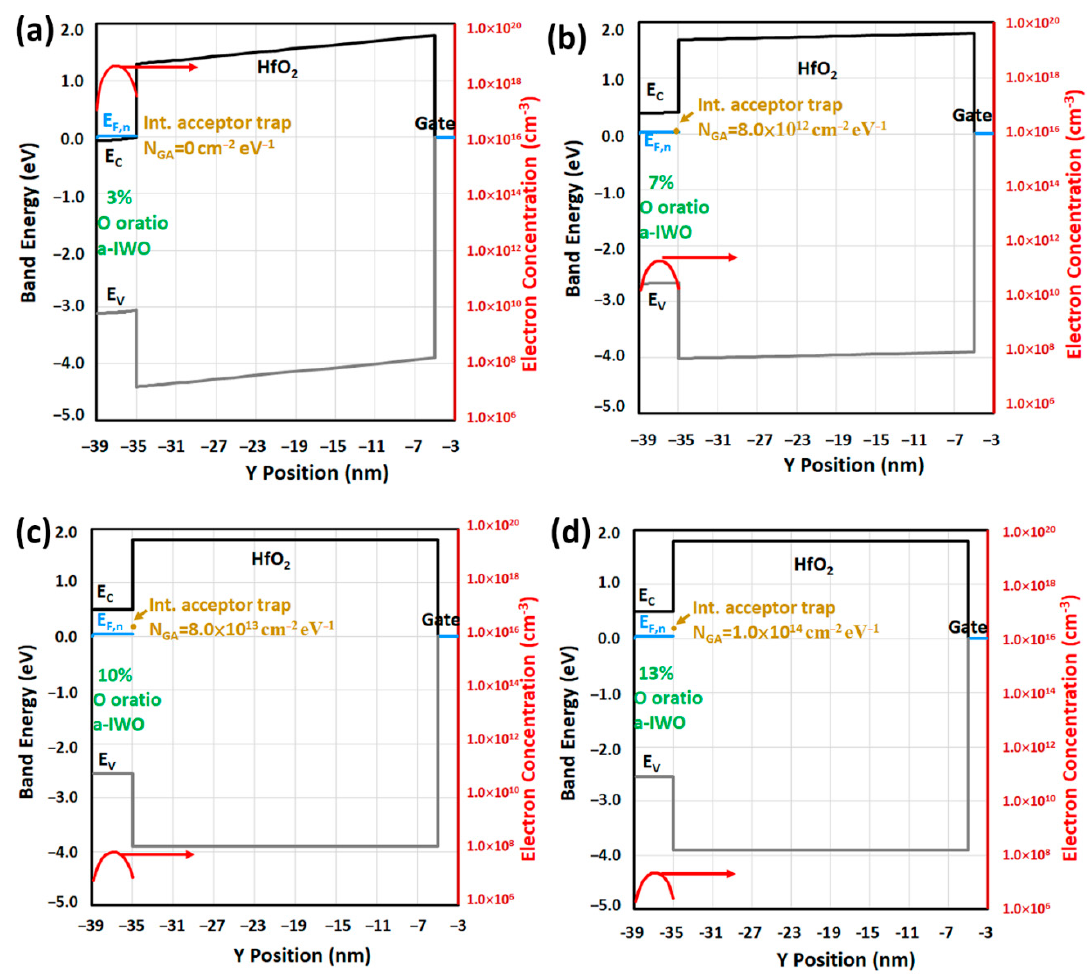
Figure 5. Under equilibrium, 1D band diagrams including electron quasi-Fermi level ( E F,n ) and electron concentration for ( a ) 3%, ( b ) 7%, ( c ) 10%, and ( d ) 13% of a-IWO TFT.